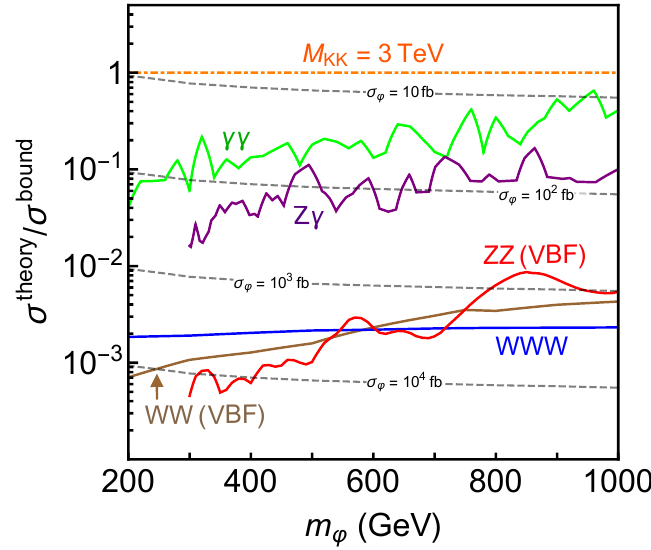
Figure 10. The ratio of cross section predicted by the warped model to the experimental bounds as a function of m ’ . Five relevant searches are shown: ATLAS diphoton (green), ATLAS diboson WW (fully leptonic, in brown), ATLAS diboson ZZ ( ‘‘qq + (cid:23)(cid:23)qq in red), CMS Z(cid:13) (leptonic, in purple), and ATLAS triboson WWW (blue). Regions below the solid lines are excluded by the corresponding experiments. The dashed lines show the scalar/radion production cross section (cid:27) ( pp ’ ), sum of both VBF and associated production. For ZZ (red) and Z(cid:13) (purple), results ! are shown only down to 300 GeV because relevant experimental search results are reported only to that point. The orange dashed dot line indicates our benchmark point with m KK = 3